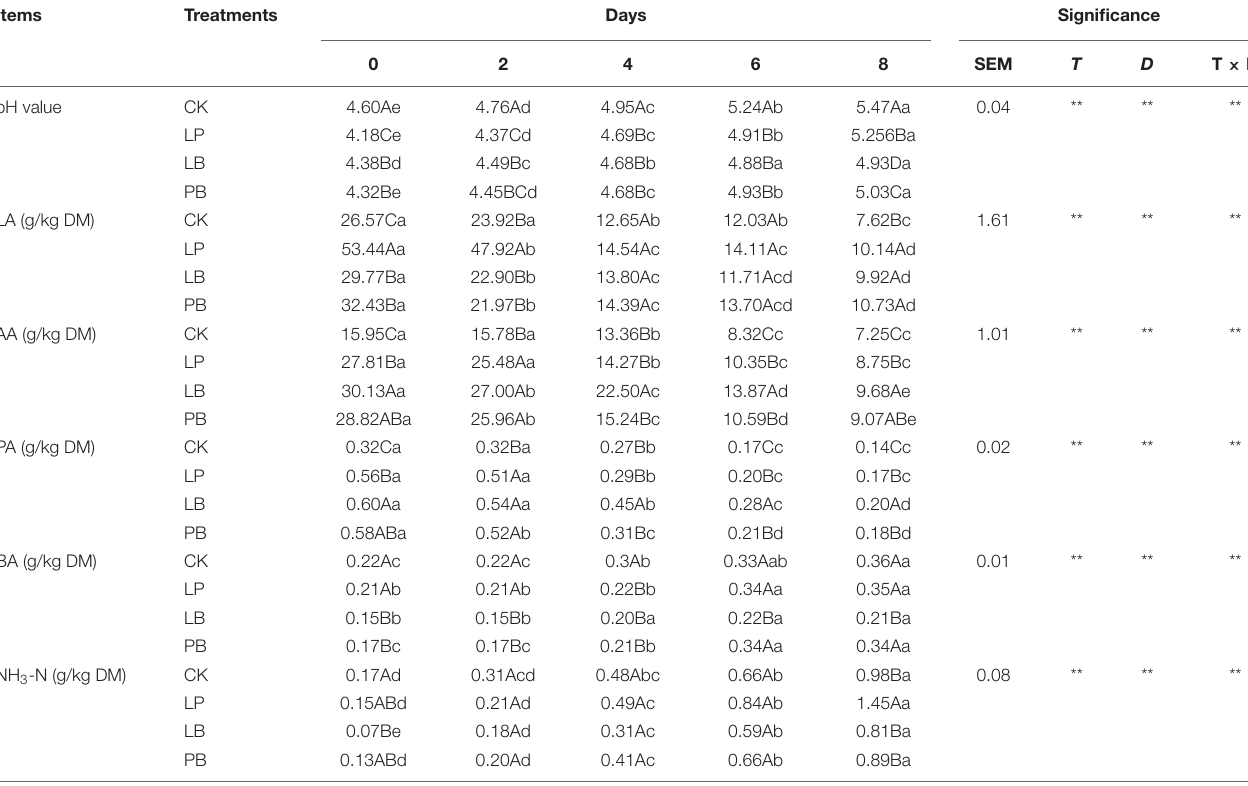
TABLE 3 | Effects of additives and days of aerobic exposure on fermentation quality of Leymus chinensis silage. Items Treatments Days